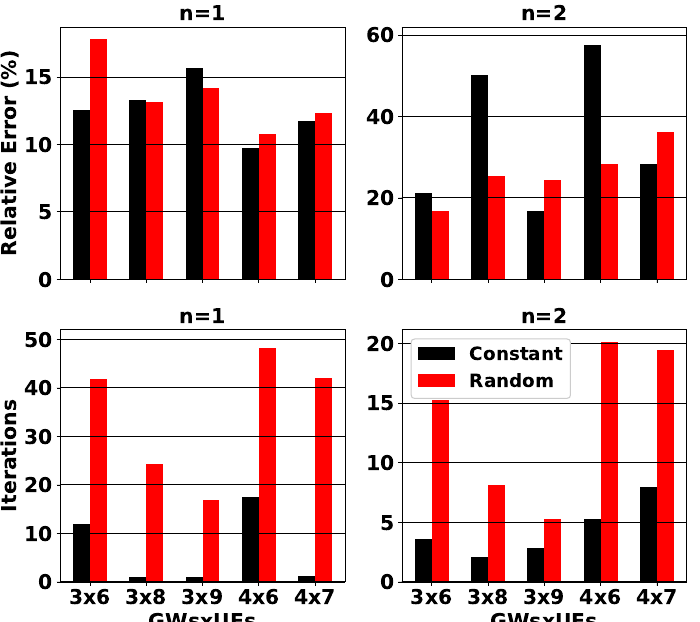
Figure 1. Average Relative Error between Exhaustive and Proposed Schemes and Average Iterations, Both with Constant and Random Initial Feasible Points, for 1st and 2nd Order Rate Matching.